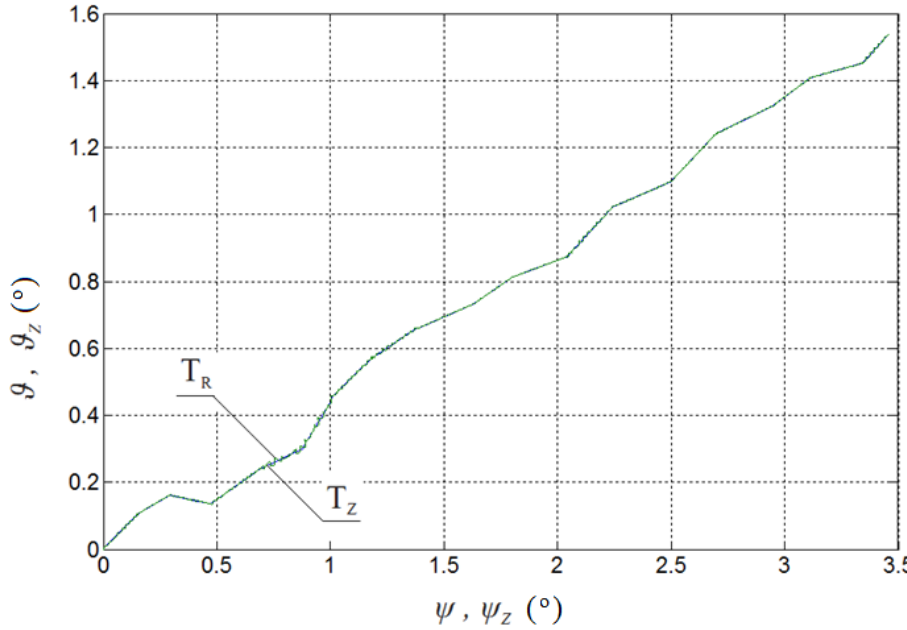
Figure 11. T Z set trajectory and pursued T R trajectory of the seeker axis with the filtration of signals received from the infrared detector.